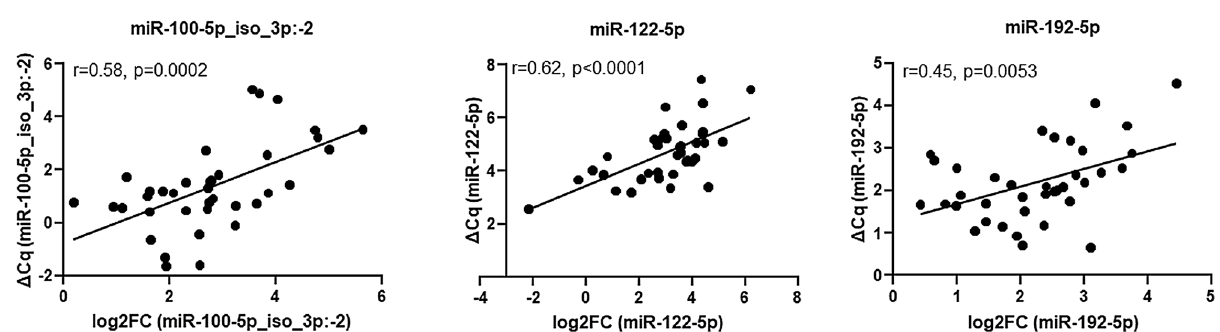
Figure 5. The study RT-qPCR assay was technically validated by high-throughput small RNA sequencing. To compare results from sequence analyses (log2 fold change [FC] in the base mean count) with results from qPCR analyses (ΔCq), a Pearson linear correlation was performed. The analytical variability between high-throughput RNA sequencing and the RT-qPCR–based assay to predict liver disease progression in individuals with HIV-1/ HCV coinfection shows a high